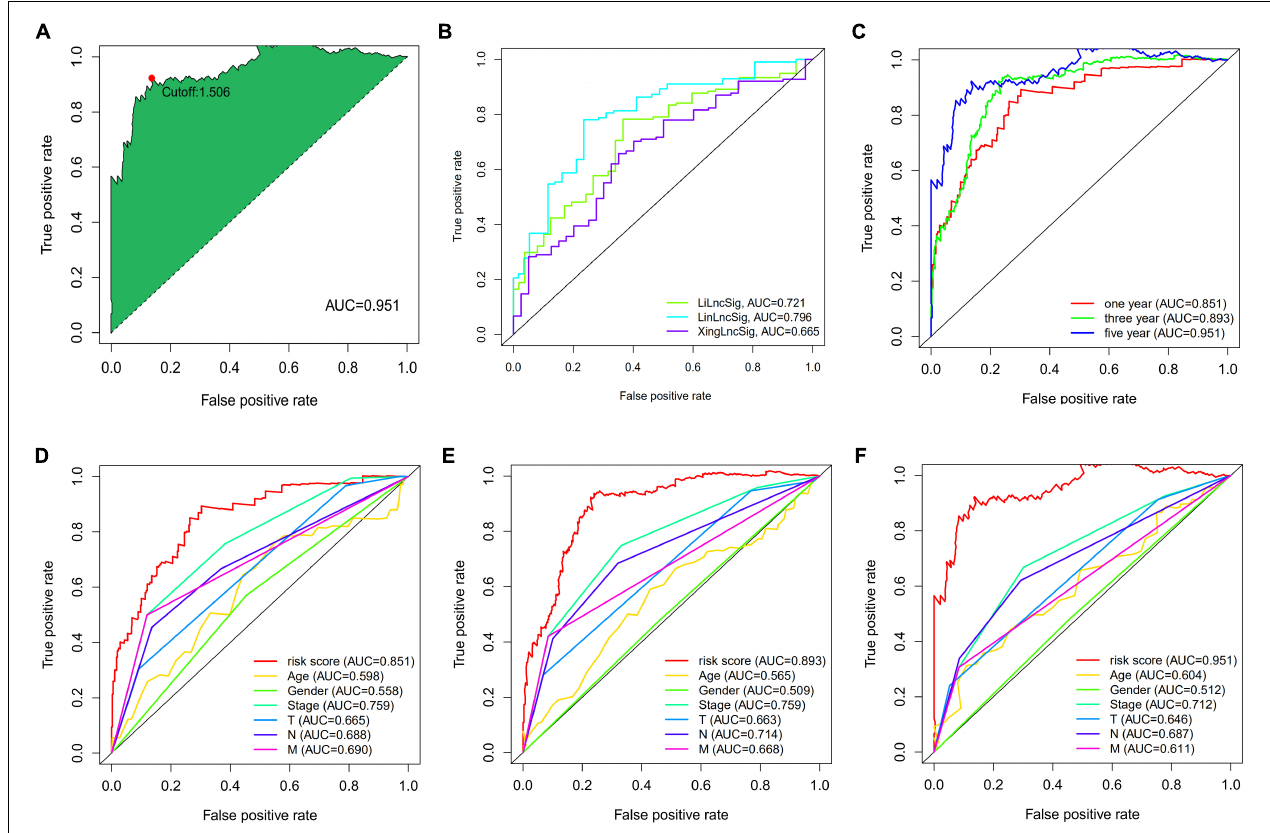
FIGURE 4 | (A) The akaike information criterion (AIC) value was calculated to identify the best cut-off point to divide patients into high-risk and low-risk groups. (B) The AUC value was much higher than the other three lncRNA-based signatures of colon cancer patients from three other studies. (C) The AUC for 1-, 3- and 5-year survival were 0.851, 0.893, and 0.951, respectively. (D–F) The AUC of other clinical-pathological features were also presented, and when compared with the constructed signature, the risk score had much better efficiency for predicting 1-, 3- and 5-year survival than the other variables in COAD